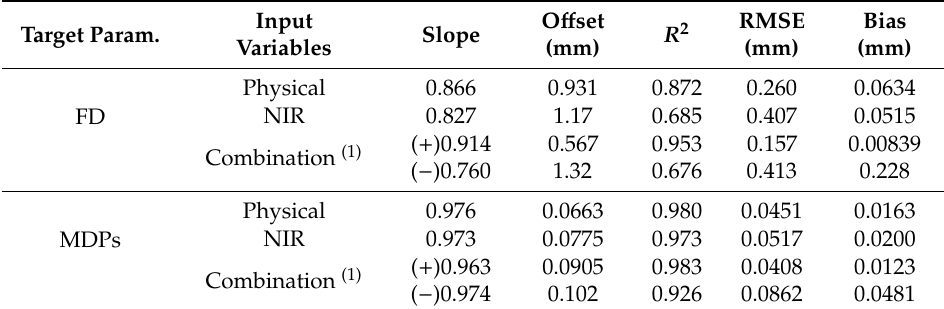
Table 6. Prediction error of FD and